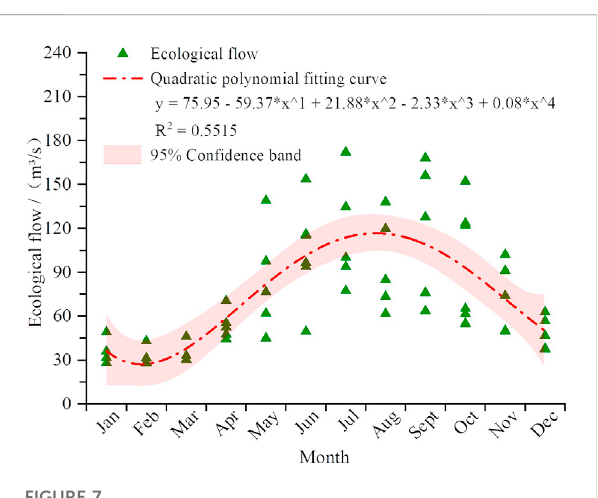
FIGURE 7 Ecological fl ow threshold fi tting